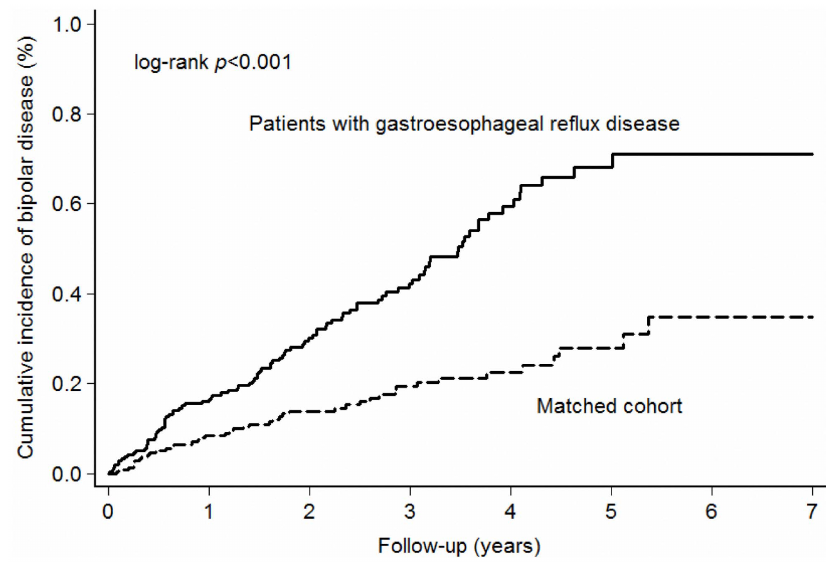
Figure 1. Cumulative incidence of bipolar disorder in patients with gastroesophageal reflux disease (GERD) and matched cohort.